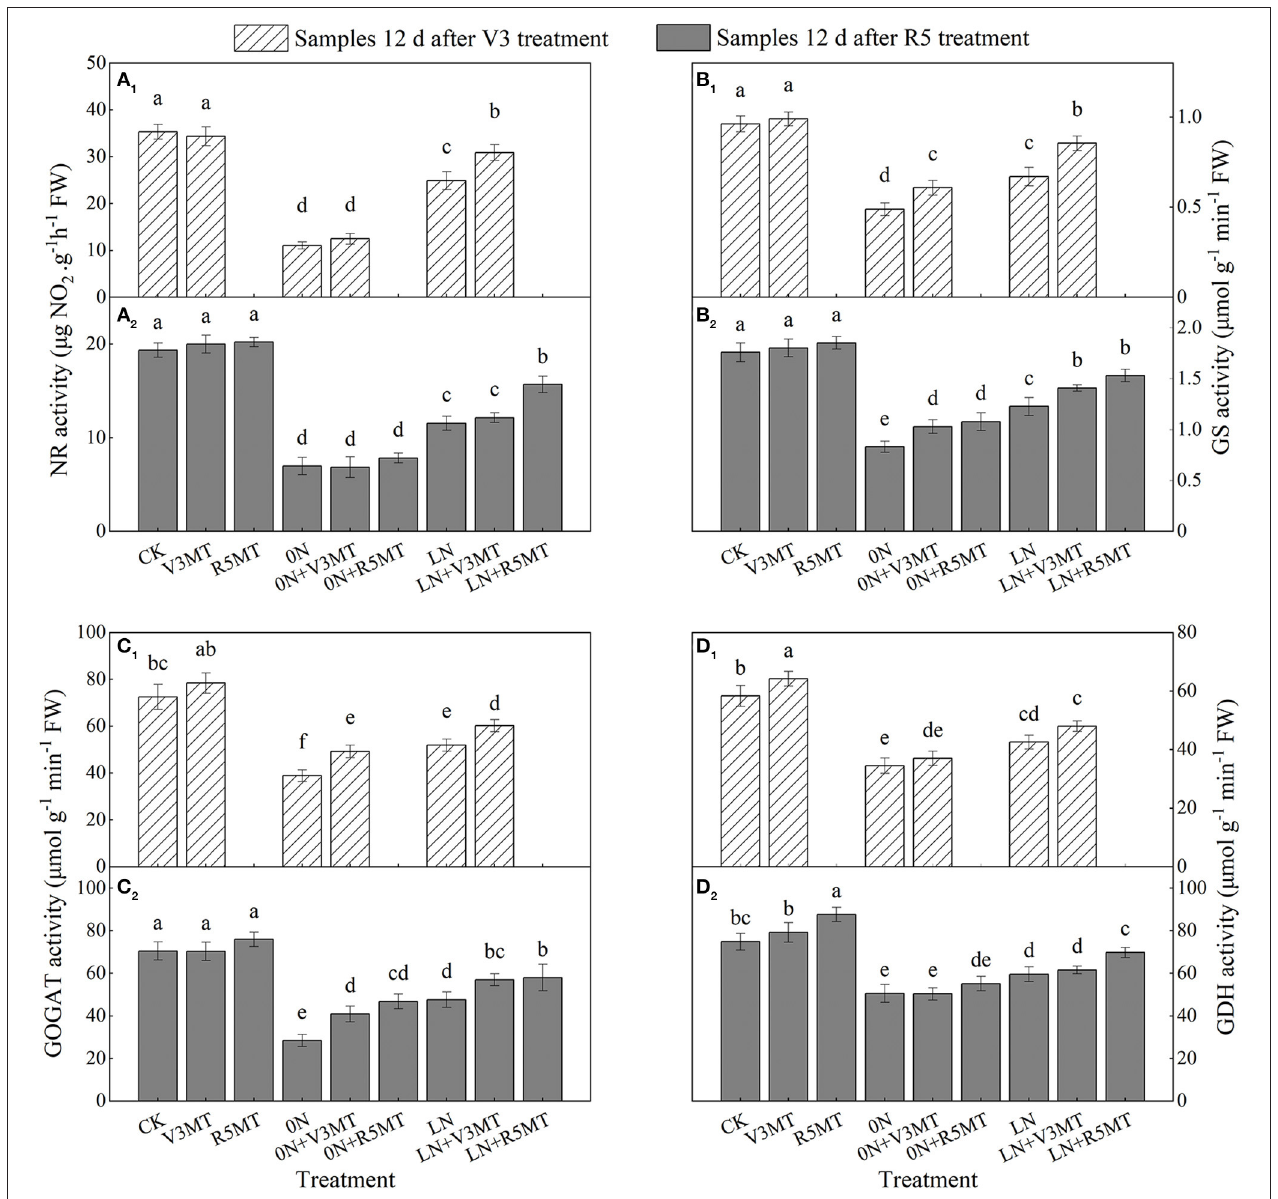
FIGURE 3 | The effect of exogenous melatonin (V3 and R5) on the activities of nitrate reductase (NR, A ), glutamine synthetase (GS, B ), glutamate synthase (GOGAT, C ), glutamate dehydrogenase (GDH, D ) in plant leaves under three N levels. CK, control nitrogen; V3MT, melatonin application at V3 stage under control nitrogen level; R5MT, melatonin application at R5 stage under control nitrogen level; 0N, zero nitrogen; 0N + V3MT, melatonin application at V3 stage under zero nitrogen level; 0N + R5MT, melatonin application at R5 stage under zero nitrogen level; LN, low nitrogen; LN + V3MT, melatonin application at V3 stage under low nitrogen level; LN + R5MT, melatonin application at R5 stage under low nitrogen level. The values were presented as mean ± SE ( n = 3). Different letters in one measuring group indicate statistically significant differences when P ≤ 0.05.